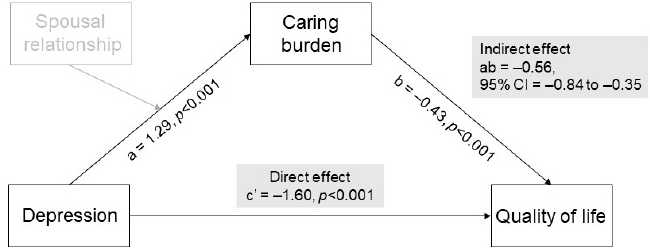
Figure 2. The mediating effect of caring burden on the relationship between depression and quality of life (Model 4).